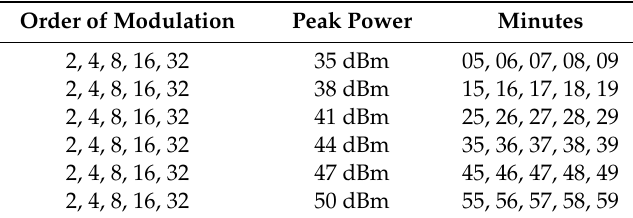
Table 2. Testbench.